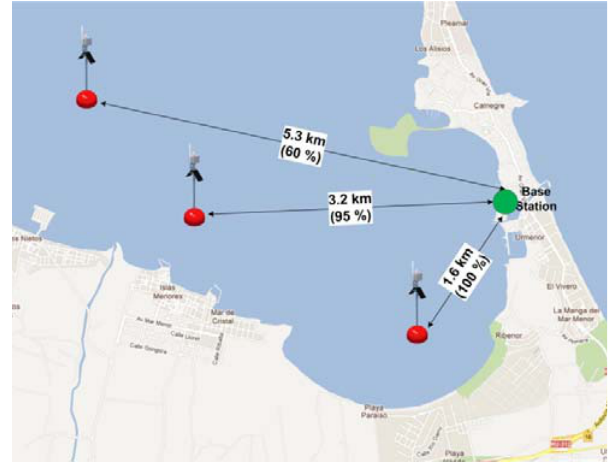
Figure 8. Coverage trials in the Mar Menor.